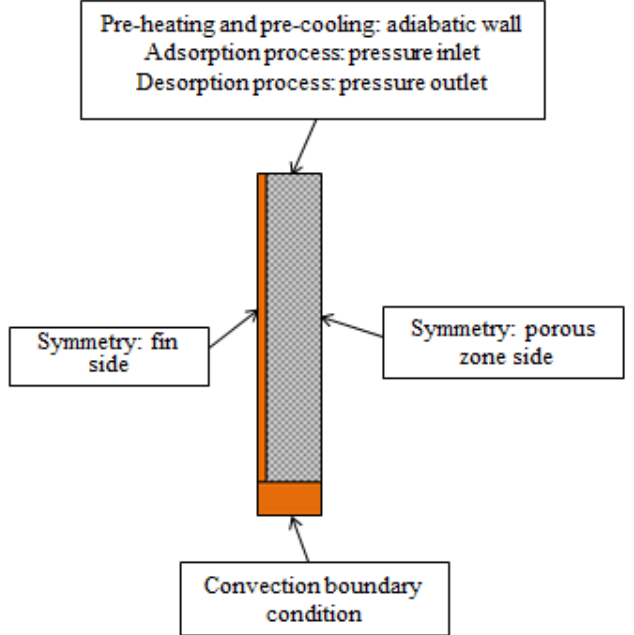
Figure 3. Domain boundary conditions.